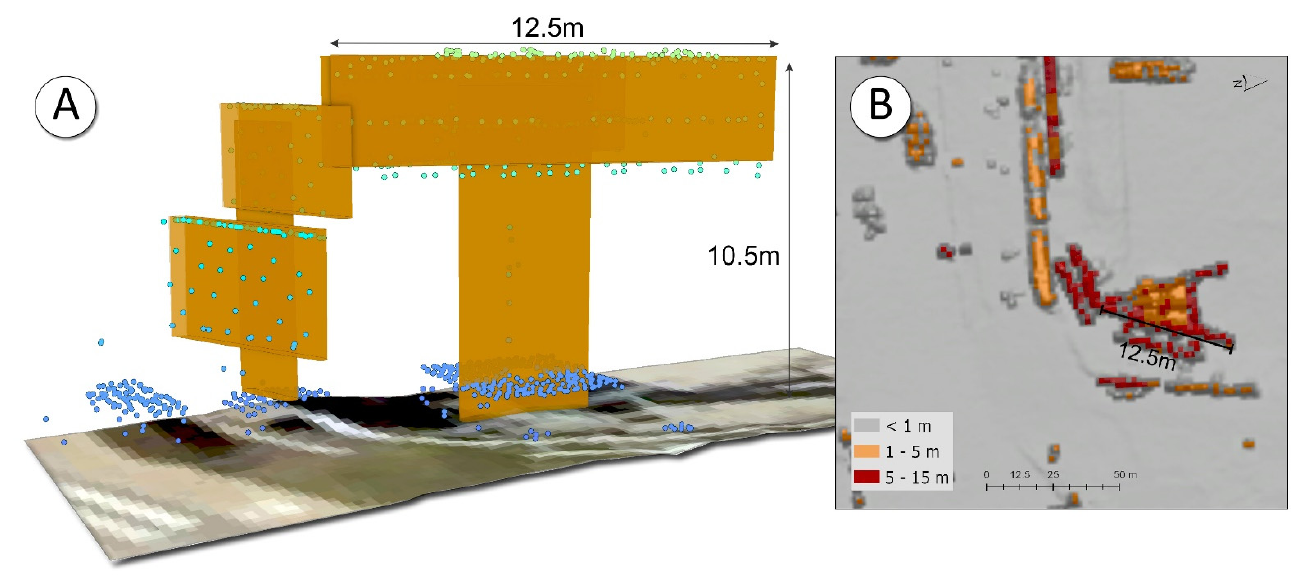
Figure 5. The profile view of a 3D point cloud representing the actual dimension of OOHb infrastructure ( A ) and high- resolution DSM of OOHb infrastructure ( B